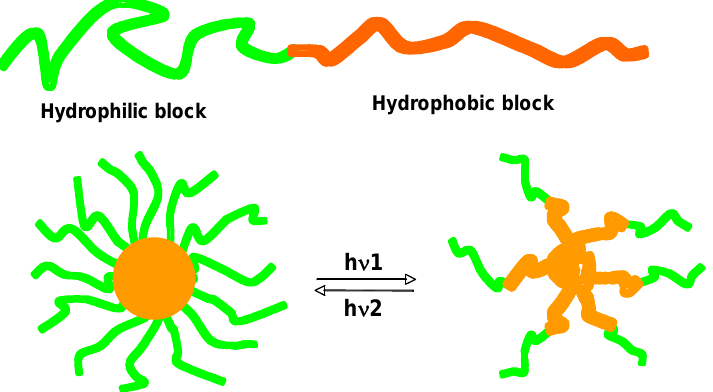
Figure 22. Schematic illustration of reversible dissociation and formation of PRBC micelles upon